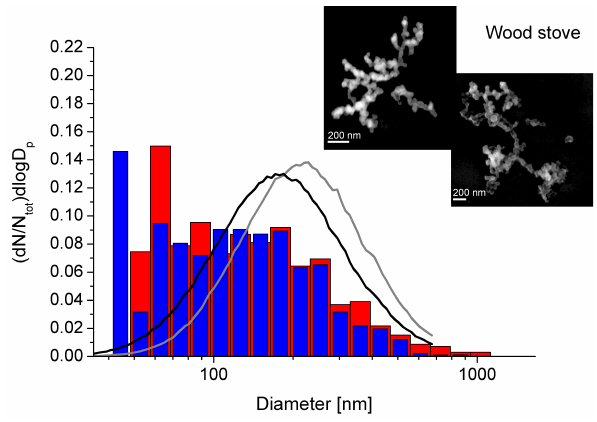
Fig. 1. Size distributions extracted from the SEM images using the equivalent projected area diameter (bars) and the electrical mobility diameter measured with the SMPS (lines) of the fresh (blue and black) and aged (red and grey) wood stove combustion particles, respectively. The insets are SEM images of a fresh (left) and aged (right) soot particle having projected area sizes of: 205nm for the small particle and 480nm for the large particle on the left, and 1µm for the aged wood particle on the